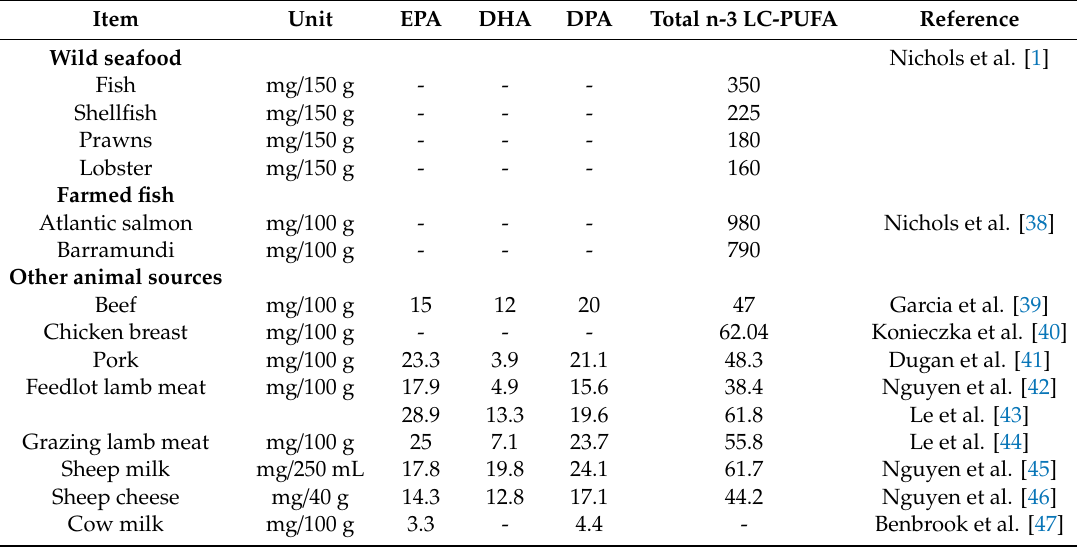
Table 2. Content of n-3 LC-PUFA in common seafood and other animal